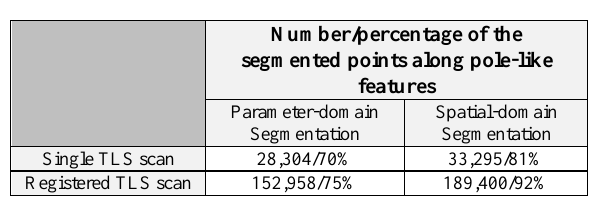
Figure 12. The cross-sectional view of three segmented pole- like features: (a) from a single scan and (b) from multiple-